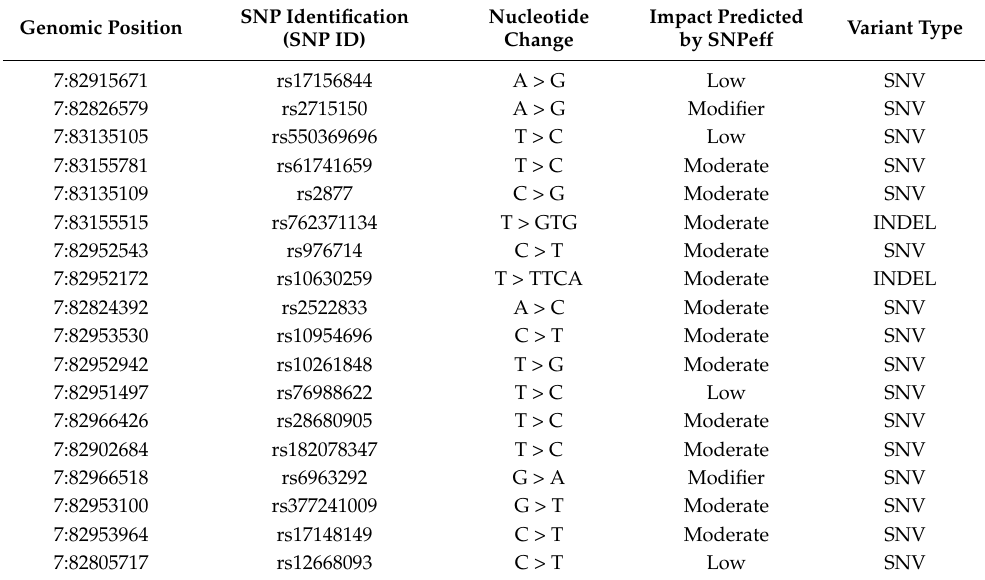
Table 1. Characteristics of the genetic markers of PCLO investigated in African, American, East Asian, European, South Asian, Brazilians from Sao Paulo and Native American populations.